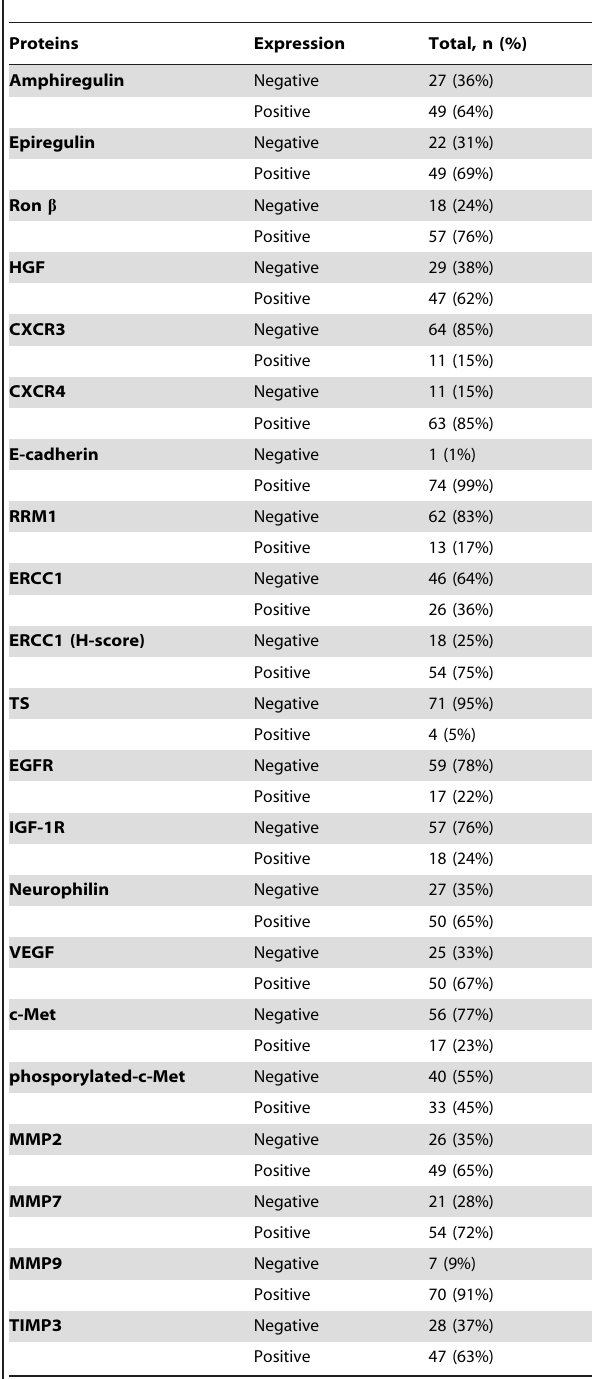
Table 2. Tissue microarray immunohistochemistry results Korean pancreatic adenocarcinoma